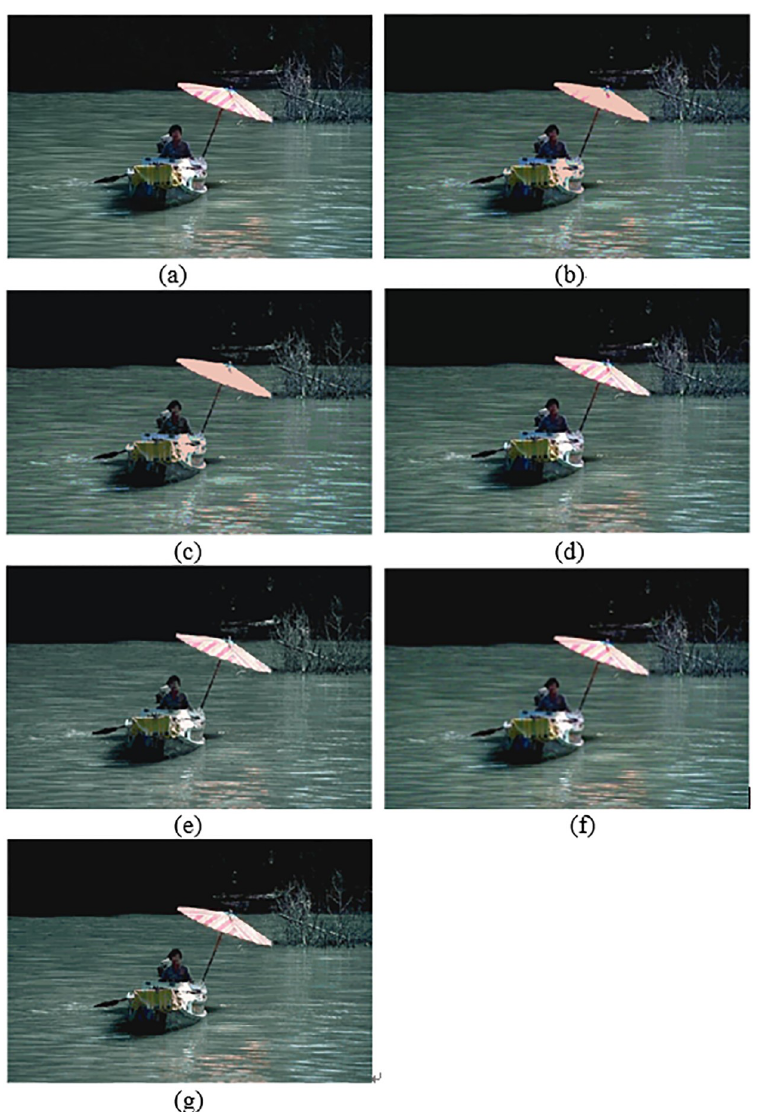
Fig 8. The image Boating : (a) original image, (b, c) initial segmented result and result after region merging based on the histon, (d, e) initial segmented result and result after region merging based on the roughness index, (f, g) initial segmented result and result after region merging based on AHHT